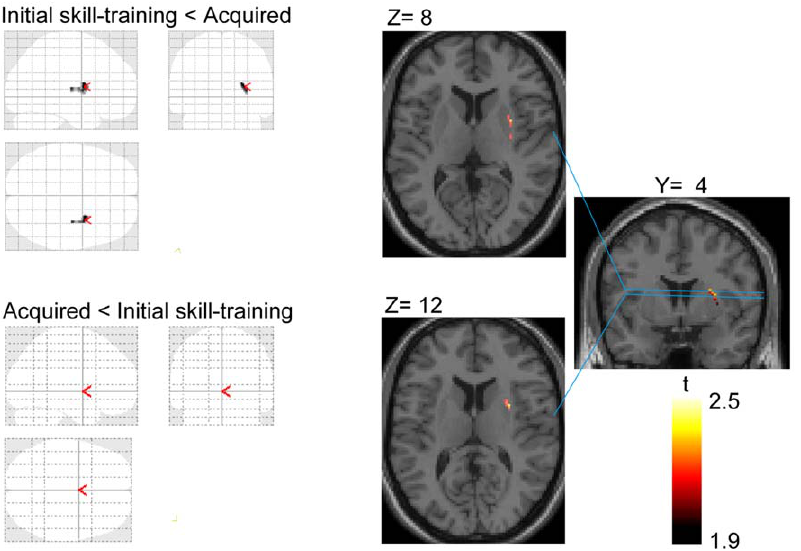
Figure 5. 11 C-raclopride BP changes in sub-regions of the striatum between the two conditions. Left panel shows the grass brain map of the voxel-based analysis of 11 C-raclopride BP change (upper figure: initial skill-training condition , acquired condition and lower figure: acquired condition , initial skill-training condition). Right panel shows coronal and axial sections of the statistical parametric map of 11 C-raclopride BP change in the initial skill-training condition versus acquired condition overlaying the MRI T1 image in stereotaxic space. Right side image corresponds to right side brain. The displayed cluster shows the significant area of decreased 11 C-raclopride BP in the right antero-dorsal and lateral part of the putamen. The peak coordinate in the right putamen was located at X=30, Y=4, Z=12. No BP change was observed in the left putamen.